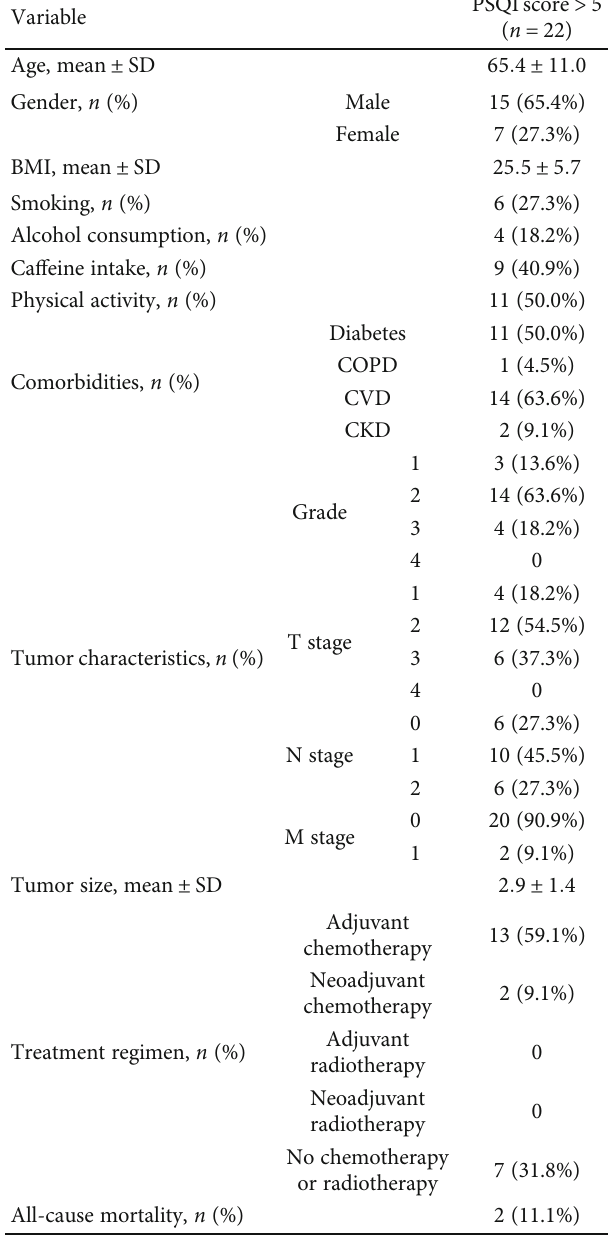
Table 2: Quality of sleep in patients